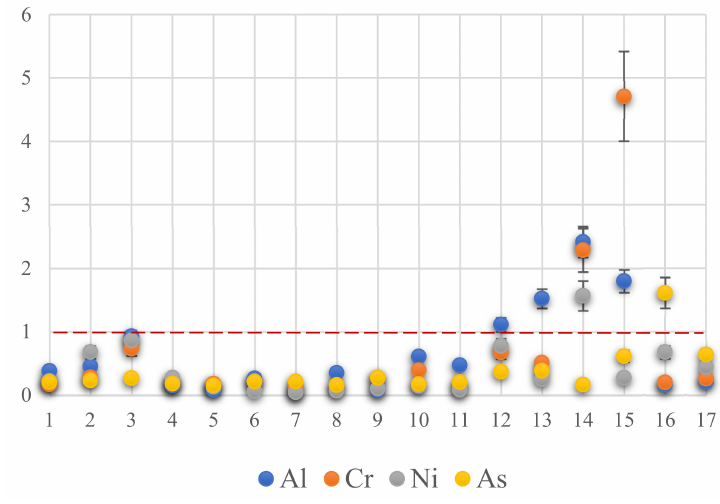
Figure 4. Risk quotients (RQ) of Al, Cr, Ni, and As in mussels from studied sites. Table 3. The maximum provisional consumption rates (MPCR) for selected